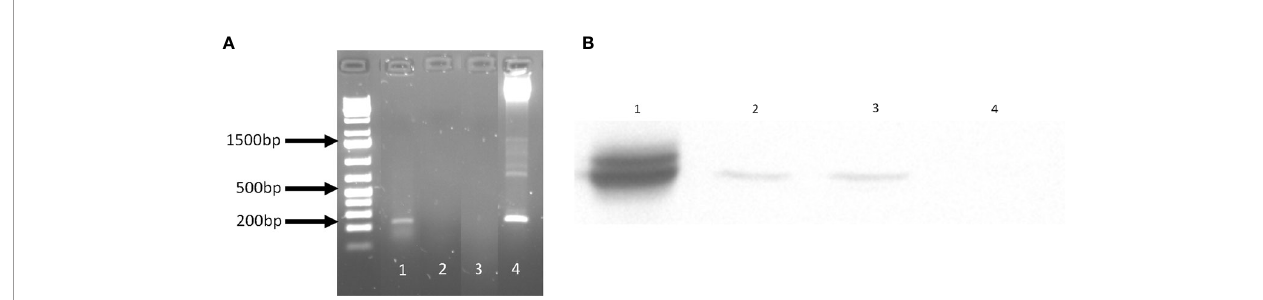
FIGURE 3 | NcSAG1 expression by Lm3Dx_SAG1. (A) NcSAG1 mRNA expression. The 200 bp band of NcSAG1 is visible in Lm3Dx_SAG1 (1), but not in the empty vector Lm3Dx (3). H 2 0 was used as negative control (2) and pMAD_NactA100AA_SAG1 plasmid DNA as positive control (4). (B) Bacterial NcSAG1 protein expression in infected cells. WB evidences a speci fi c band of NcSAG1 protein expression at 35kDa in DH82 cells infected with Lm3Dx_SAG1HIS (2) and Lm3Dx_SAG1 (3), but not in DH82 cells infected with the empty vector Lm3Dx (4). Nc crude extract was used as positive